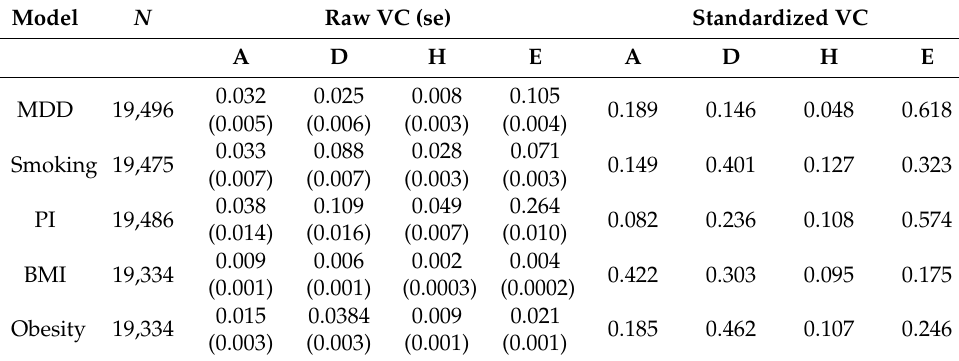
Table 4. Maximum-likelihood (co)variance component estimates and derived correlation estimates between major depressive disorder and four lifestyle factors: smoking behavior, physical inac- tivity, body-mass index, and obesity. All models included sex, age, and age 2 as fixed covariates. MDD = major depressive disorder; PI = physical inactivity; BMI = body-mass index; VC = vari- ance component; se = standard error; A = additive genetic component; D = non-additive genetic component; H = household component; E = unique environment component. Model N Raw VC (se)